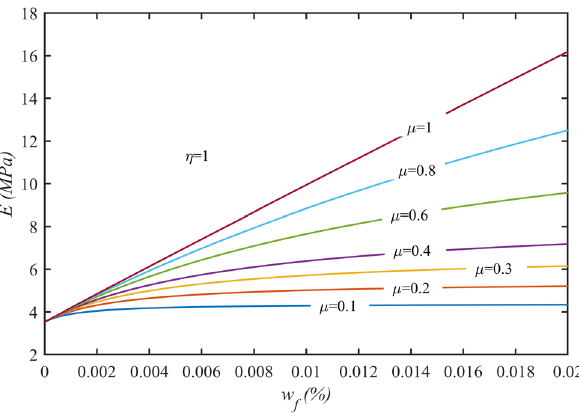
Figure 8: Young ’ s modulus of PDMS/MWCNT nanocomposite obtained from EMT ’ s approach versus MWCNT weight fraction for di ff erent MWCNT cluster sizes when η = 1.